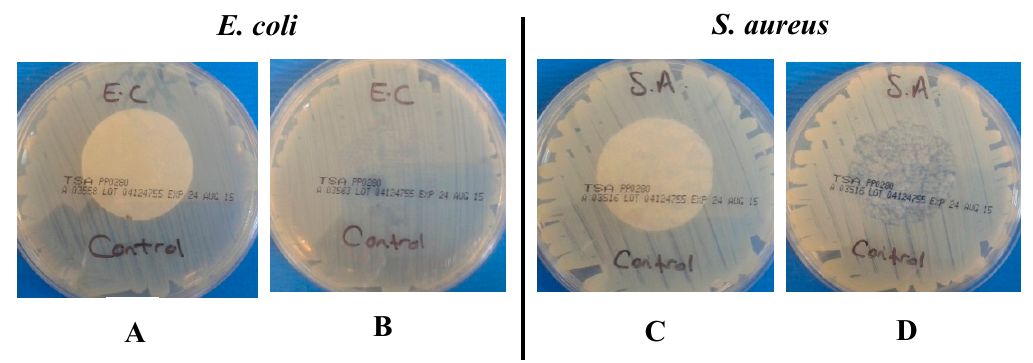
Figure 1. Effect of control samples on the growth of E. coli during ( A , C ) and following ( B , D ) incubation; A = no inhibition zone; B = heavy growth under sample and S. aureus ; C = no inhibition zone and D = heavy growth under sample. Note: all samples were 3 cm in diameter.